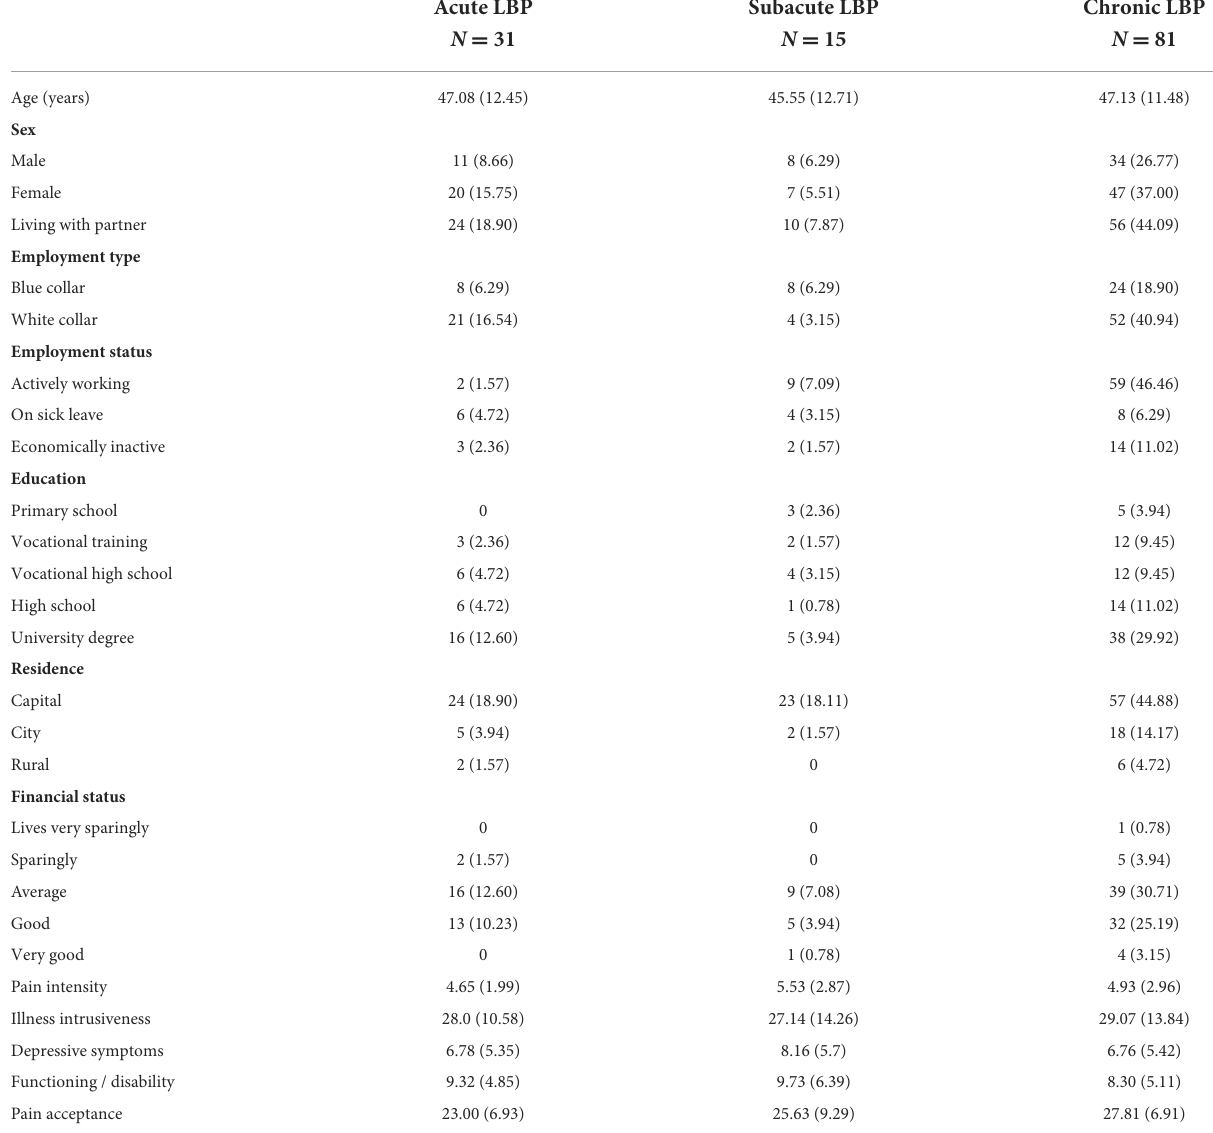
TABLE 1 Characteristics of the sample at recruitment [categorical variables are characterized by occurrence and percentage, while continuous variables (age and scale scores) by mean and standard